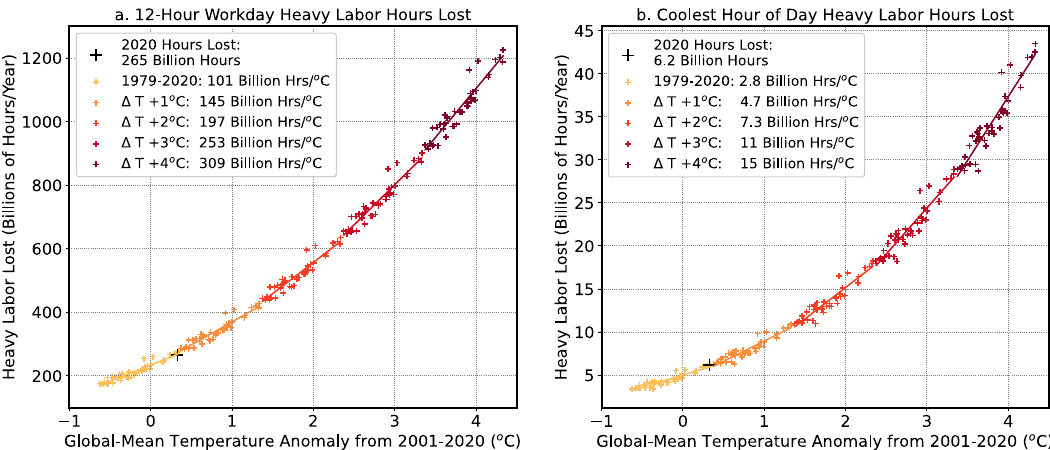
Fig. 3 Relationship among global air temperature and labor losses. Global-mean temperature anomalies (relative to the 2001 – 2020 mean) and global sums of heavy labor lost for the full 12-h workday ( a ) and for the coolest hour of the day ( b ) for 1979 – 2020 and with + 1 °C, + 2 °C, + 3 °C, and + 4 °C of additional global warming. Darker colors indicate higher warming levels. For future warming relationships, Coupled Modeling Intercomparison Project, Phase 6 (CMIP6) simpli fi ed Wet Bulb Globe Temperatures (sWBGT) warming patterns (Supplementary Fig. 5) are added to the 1979 – 2020 reanalysis- based sWBGT data for each global temperature change ( + 1 °C, + 2 °C, + 3 °C, + 4 °C). Lines show best- fi t regression lines for the given climate state (1979 – 2020, + 1 °C, + 2 °C, + 3 °C, + 4 °C), and the legend lists the slopes of these regression lines. Crosses mark global sums of heavy labor hours lost for individual years, with the year 2020 shown in a black